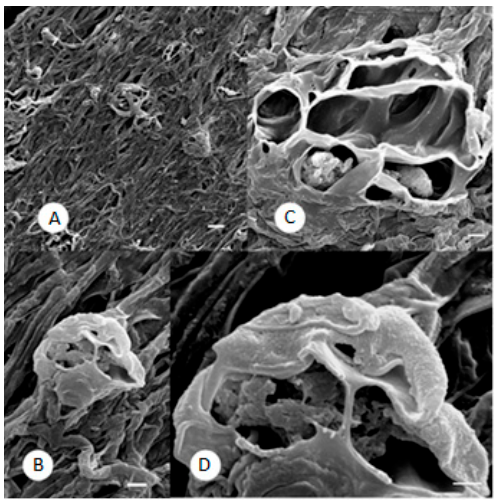
Figure 4. M. gypseum treated with 200 μ g/mL phenylethylresorcinol. ( A ) Compact mycelium with hyphae fused together and some stretch marks. SEM. Scale bar: 10 μ m; ( B ) Strange formations in the